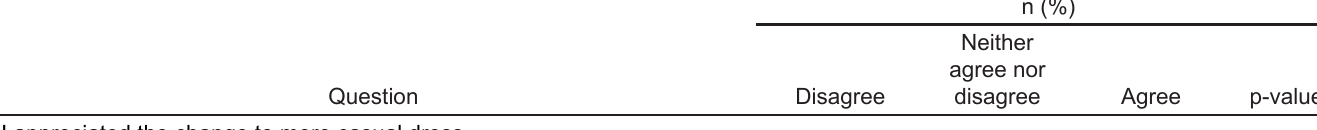
Table 3 . Response frequency to each survey question stratified by